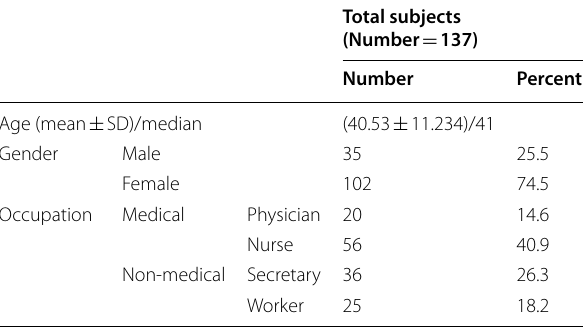
Table 1 Demographics of total sample